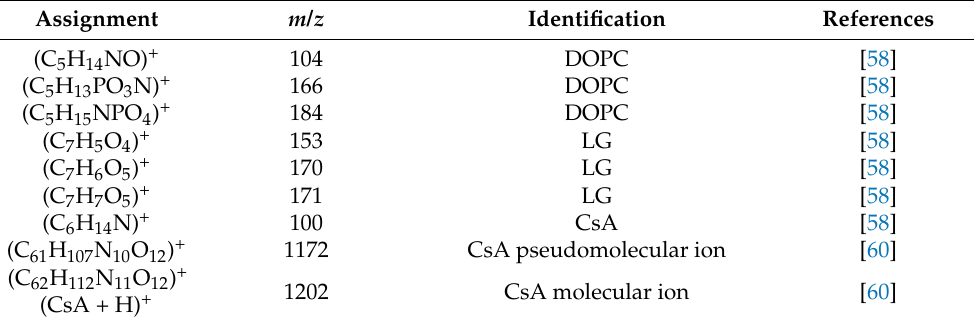
Table 2. The most characteristic positive fragments of DOPC, LG, and CsA in the TOF-SIMS mass spectra.